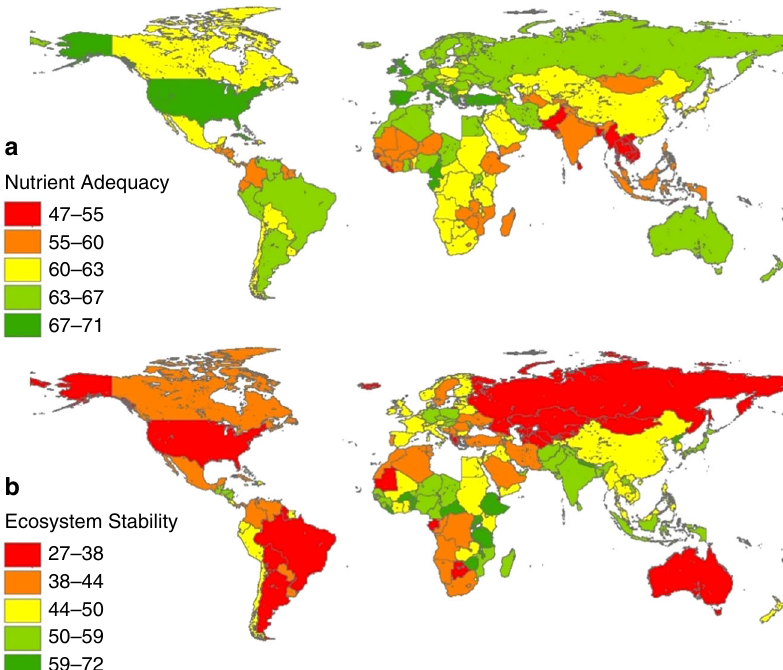
Fig. 3 Nutrition and Environmental metrics scores per country. a Food Nutrition Adequacy and b Ecosystem Stability scores for all countries calculated in this study (based on data for the year 2011). Metric score is arithmetic average of its underlying indicator scores (normalized to 0 – 100). Symbology based on Jenks natural breaks classi fi cation method. It can be seen that most countries with high Food Nutrient Adequacy score low on Ecosystem Stability, pointing toward high environmental impacts associated with their diets (see Supplementary Data 1 for all